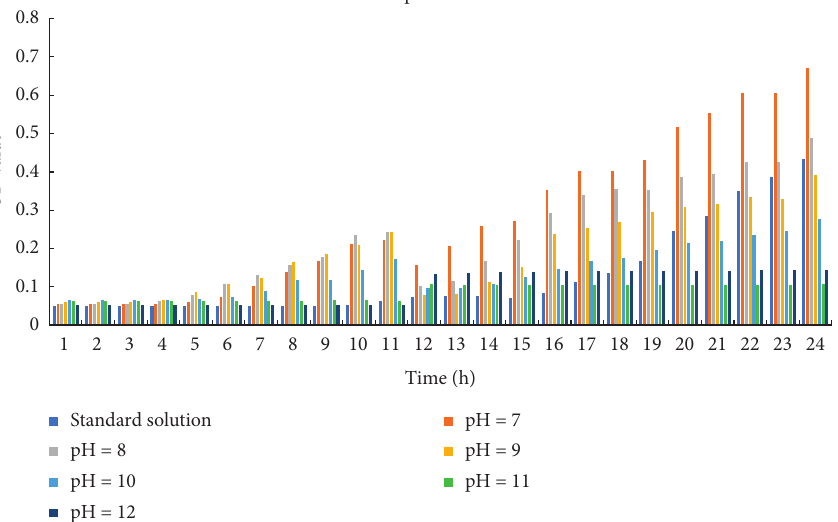
Figure 1: Effects of pH value on Bacillus sphaericus .